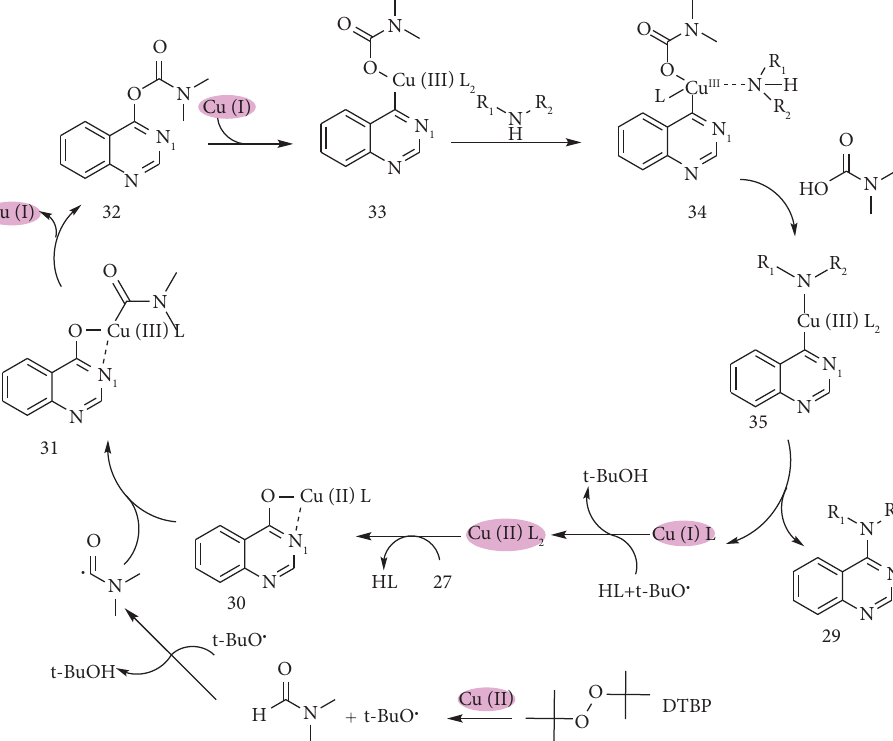
2 as a catalyst and